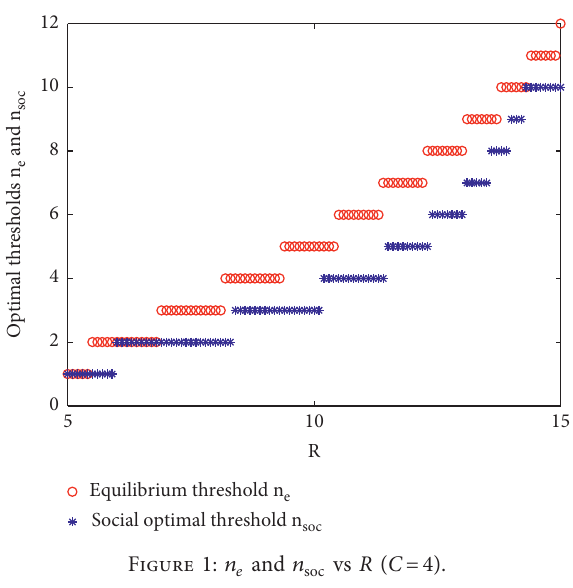
n vs R ( C � 4). e and soc